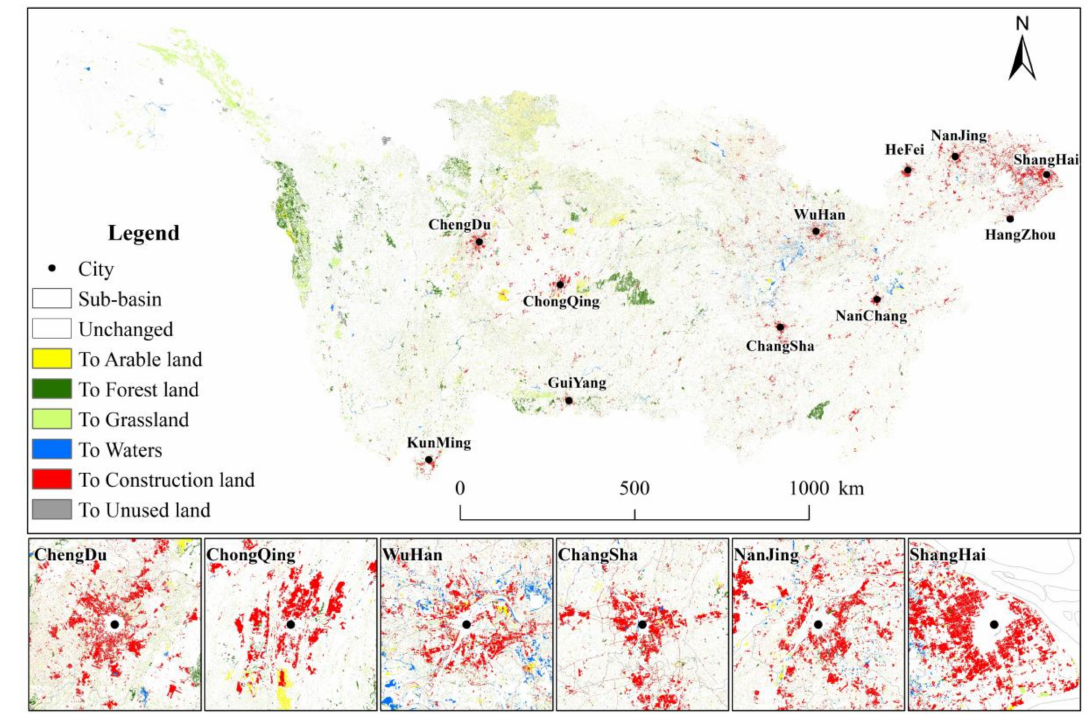
Figure 14. Spatial distribution of land use type change in Yangtze River Basin from 2000 to